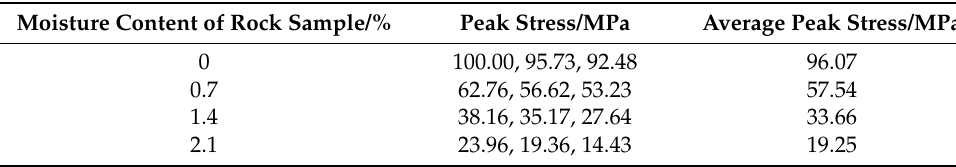
Table 3. Peak stress of rock samples with different water